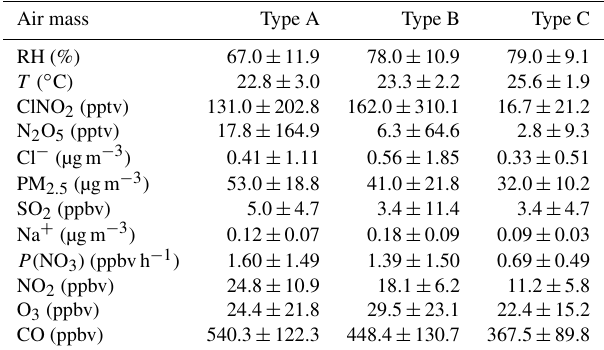
Table 3. Statistics results (median ± standard deviation) of the re- lated parameters in the three types of air masses (from 18:00 to